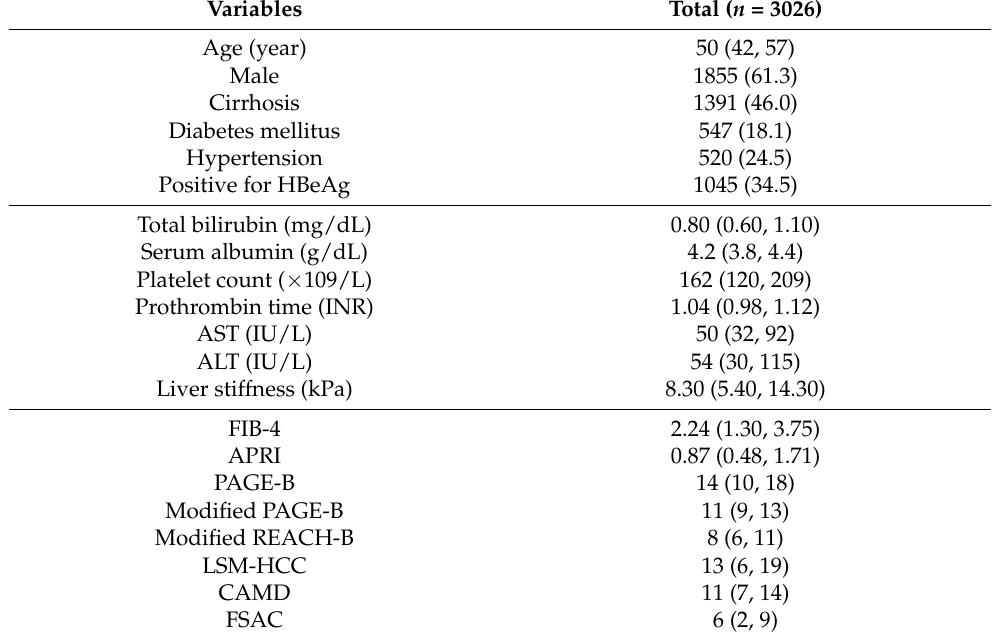
Table 1. Baseline clinical characteristics of the study population.